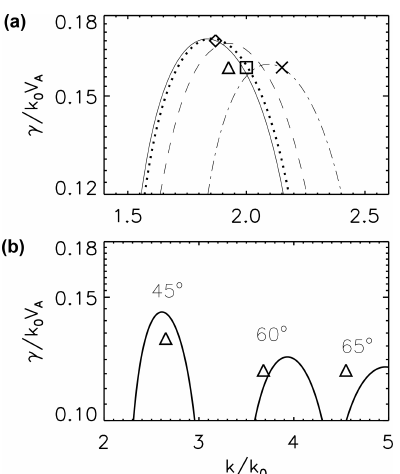
Figure 4. Growth rates of decay instability in the wavenumber do- main of the daughter modes for propagation angles of 0 ◦ (solid), 10 ◦ (dotted), 20 ◦ (dashed), and 30 ◦ (dashed dotted) estimated by the analytical dispersion analysis (a) . Overplotted by diamond, tri- Figure 3. Spectrum for the magnetic field δB 2 (ω, k ) and den- angle, square, and cross symbols are the growth rates obtained in sity ρ 2 (ω, k ) fluctuations at the latest time of the simulation the three-dimensional hybrid simulation for the above propagation ( t(cid:127) p ≈ 600). Slices at wavenumber k ⊥ = 0 (a) display the Alfvén angles, respectively. Panel (b) shows the same comparison at larger pump wave A 1 ( k (cid:107) V A /(cid:127) p ∼ 0 . 2), Alfvén A ( 0 ) ( k (cid:107) V A /(cid:127) p ∼ − 0 . 2), 2 propagation angles, 45, 60, and 65 ◦ and ion acoustic S ( 0 ) ( k (cid:107) V A /(cid:127) p ∼ 0 . 4) daughter modes in the 2 frequency–wavenumber domain parallel to the mean magnetic field. Slices at the frequency of the Alfvén A ( 0 ) and density S ( 0 ) 2 2 field-aligned modes are drawn in the perpendicular and parallel wavenumber domain in panel (b) . The vertical extension on the left ( k (cid:107) V A /(cid:127) p ∼ − 0 . 2) is for the Alfvén mode and that on the right ( k (cid:107) V A /(cid:127) p ∼ 0 . 4) is for the sound mode.